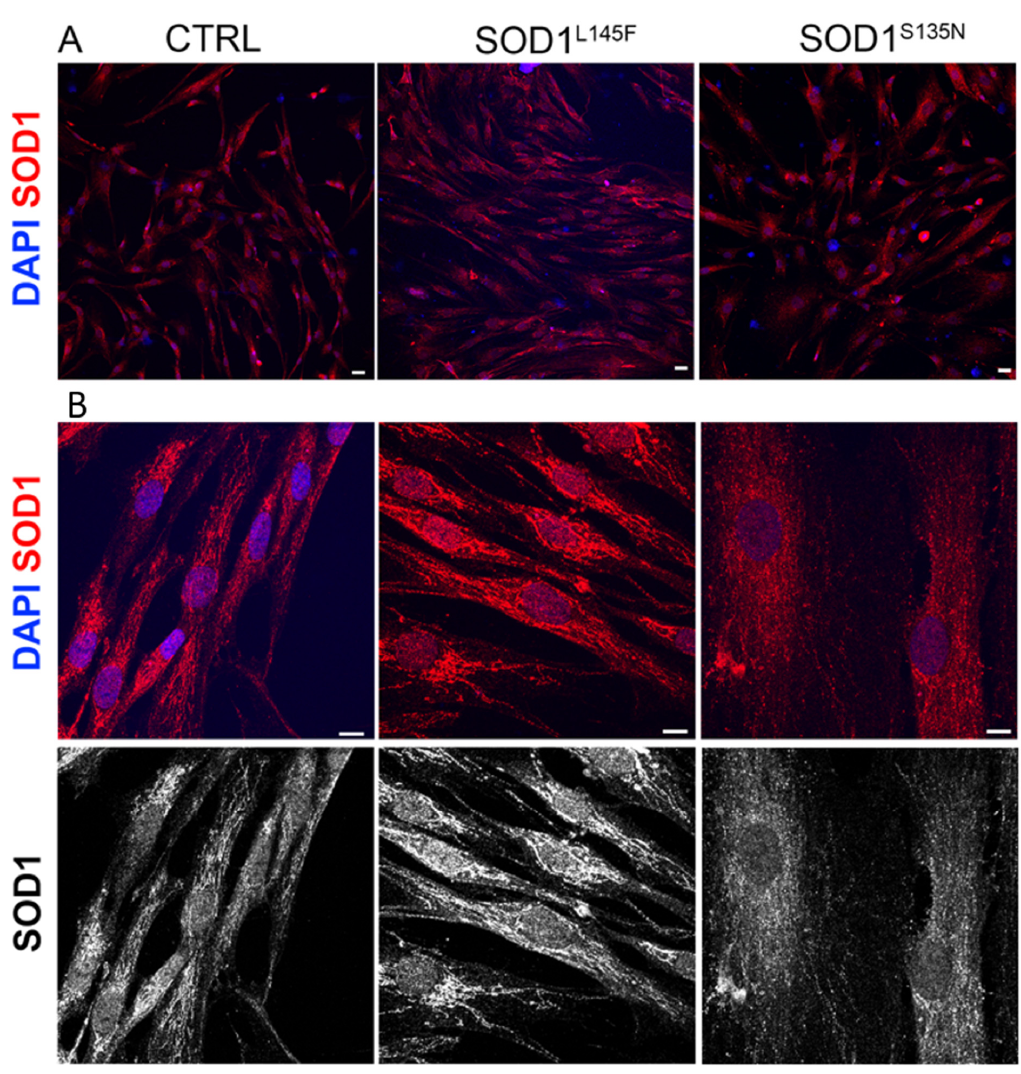
Figure 2. Representative immunofluorescence of SOD1 expression (anti-SOD1; red); nuclei are stained in blue (4 ′ ,6-diamidino-2-phenylindole, DAPI). Scale bars: ( A ) = 25 µm; ( B ) = 10µm.